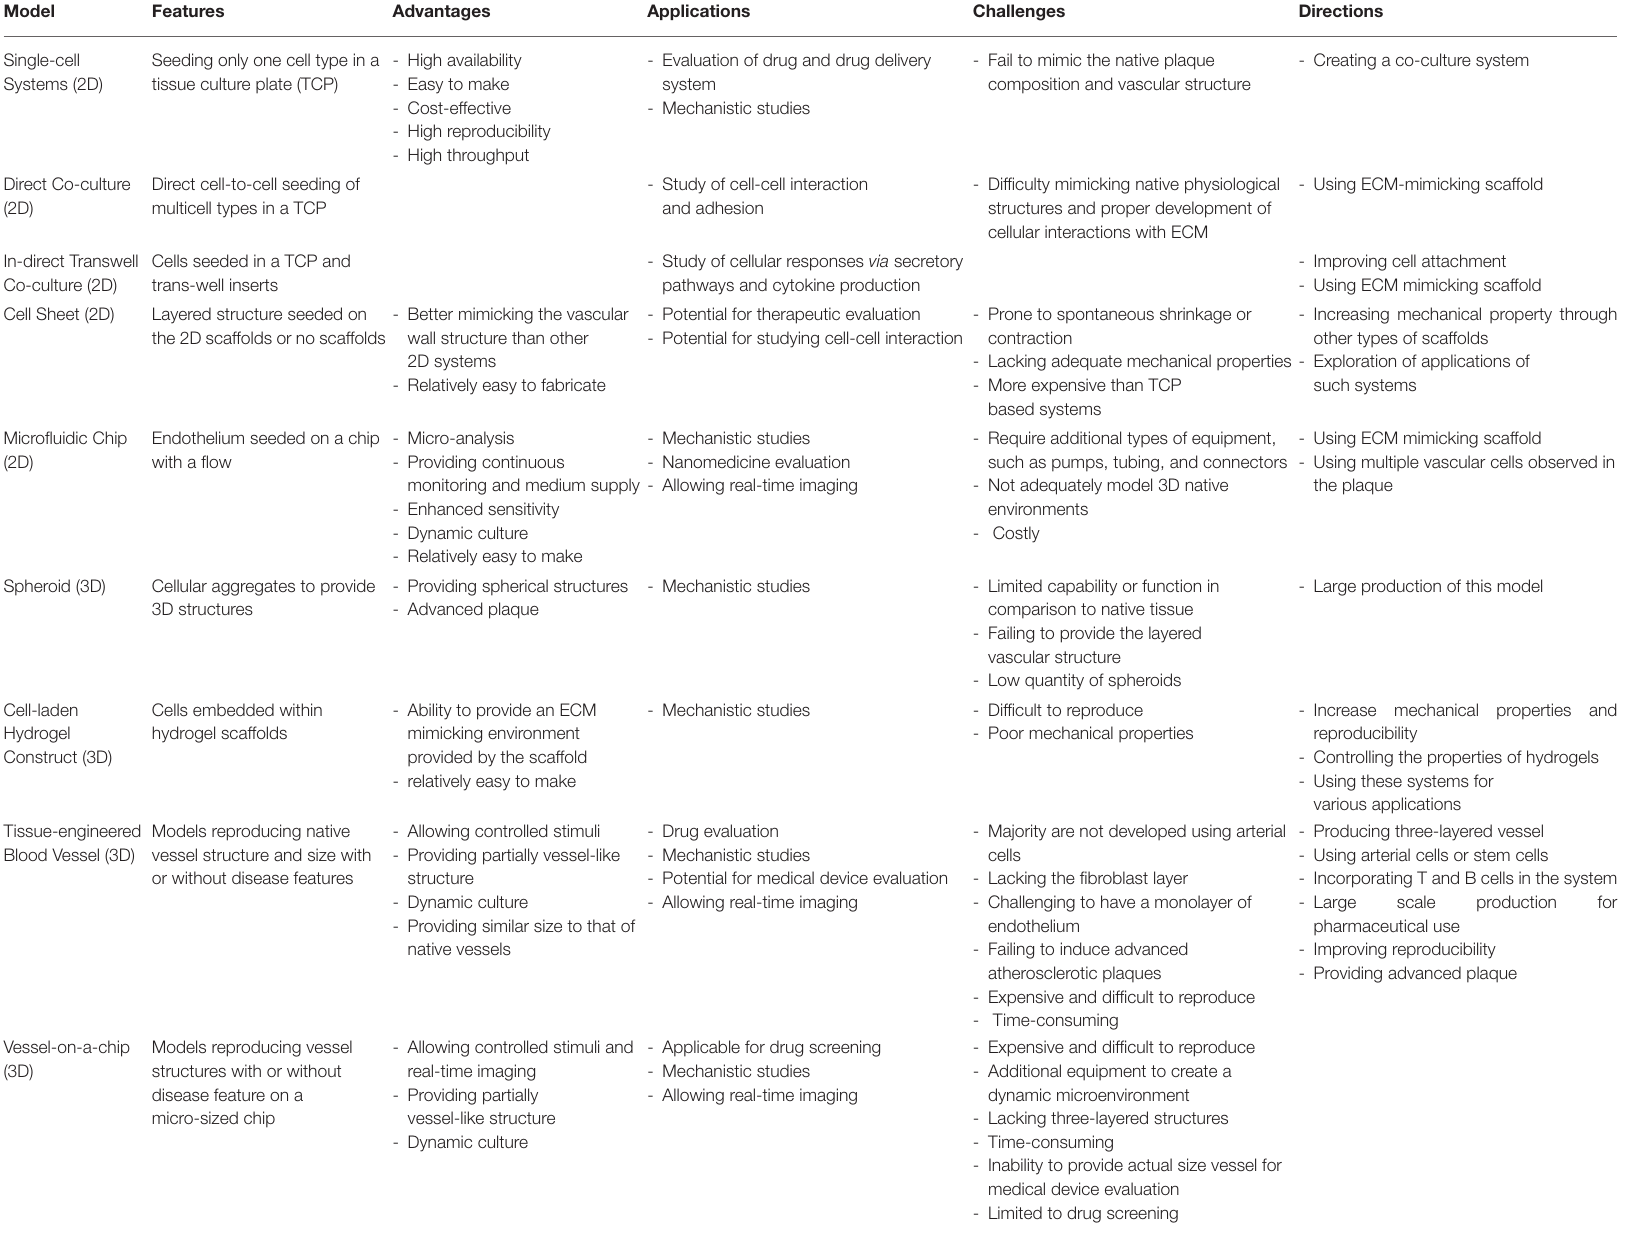
TABLE 4 | Summarize the features, advantages, application, challenges, and future directions of models discussed in the